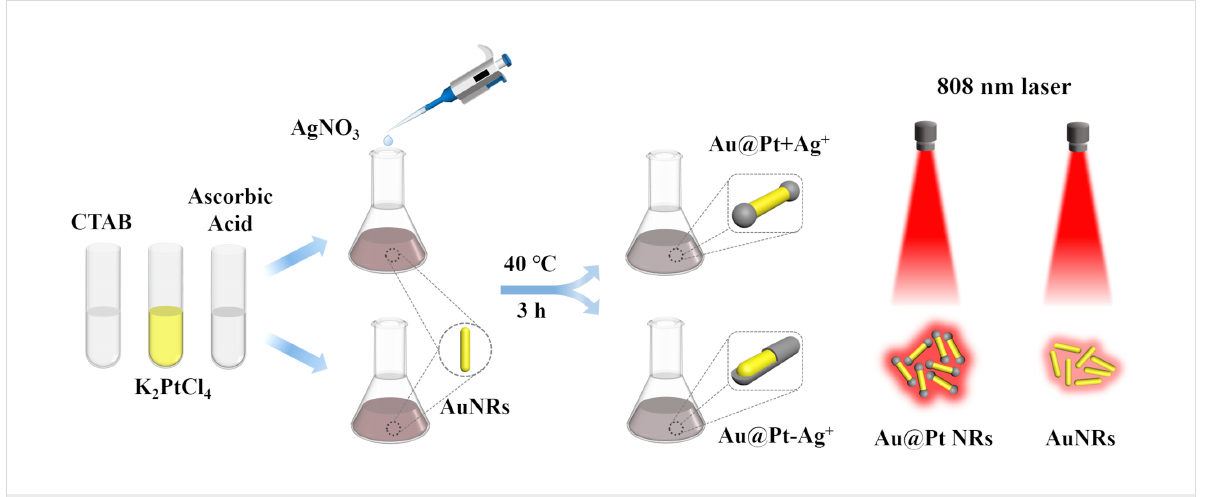
Scheme 1: Schematic illustration of the synthesis and photothermal of the Au@Pt